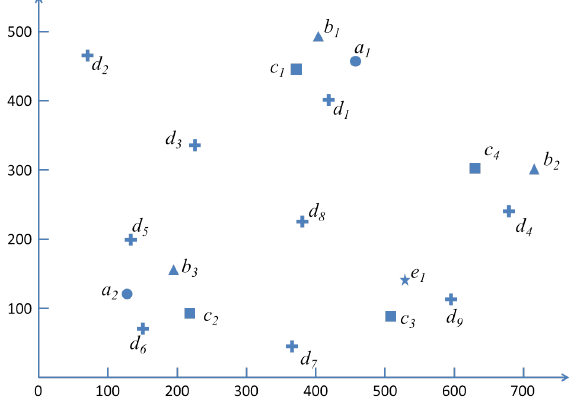
Figure 1. An example of a 2-dimensional